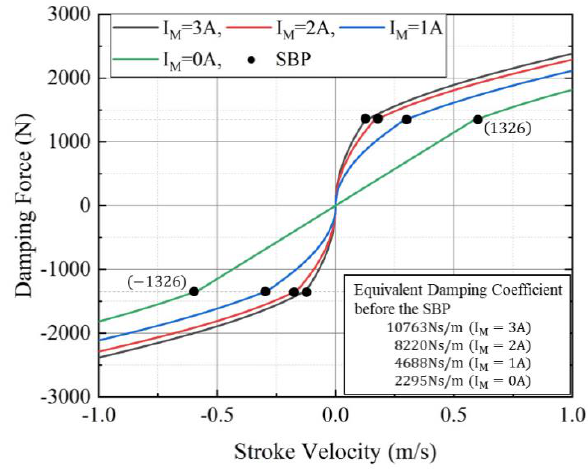
Figure 13. Damping force shaping by damping coefficient control.